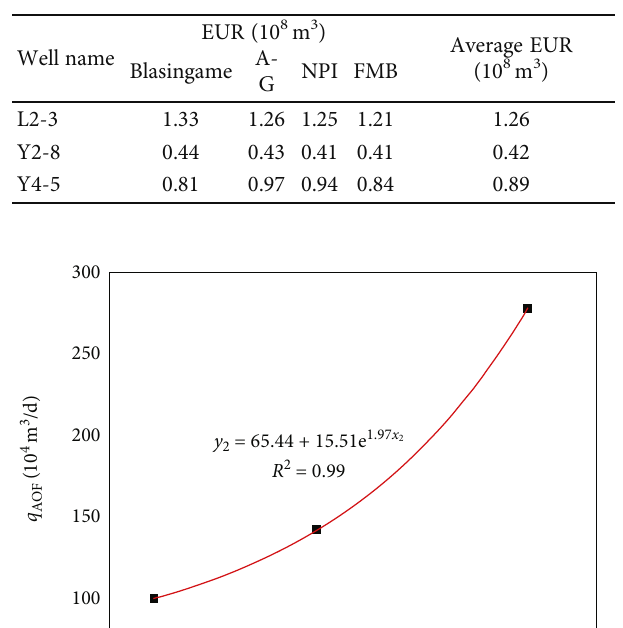
Table 7: Calculation results of modern production decline analysis methods.